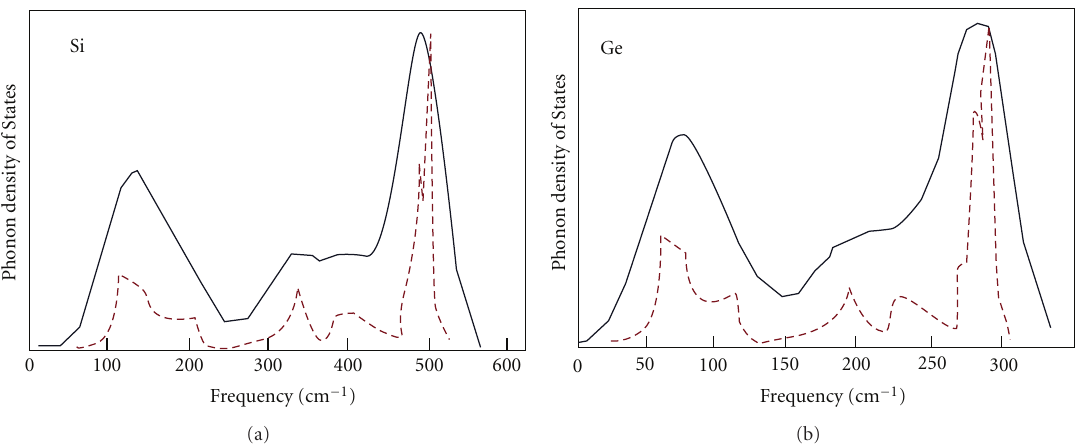
Figure 3: Calculated phonon density of state for Si (a) and Ge (b). Solid lines represent a highly disordered material, and the dashed lines represent the crystalline material